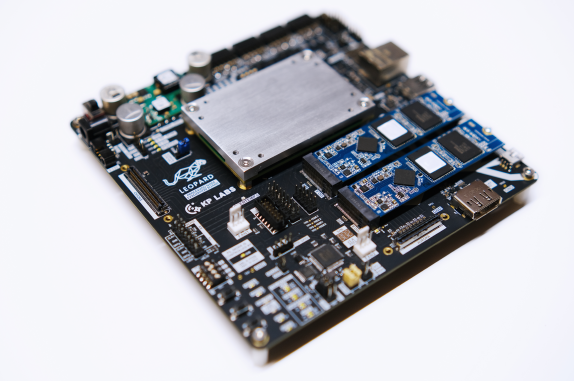
Figure A1. The block diagram of the KP Labs Leopard DPU Evalboard used for laboratory benchmarks.